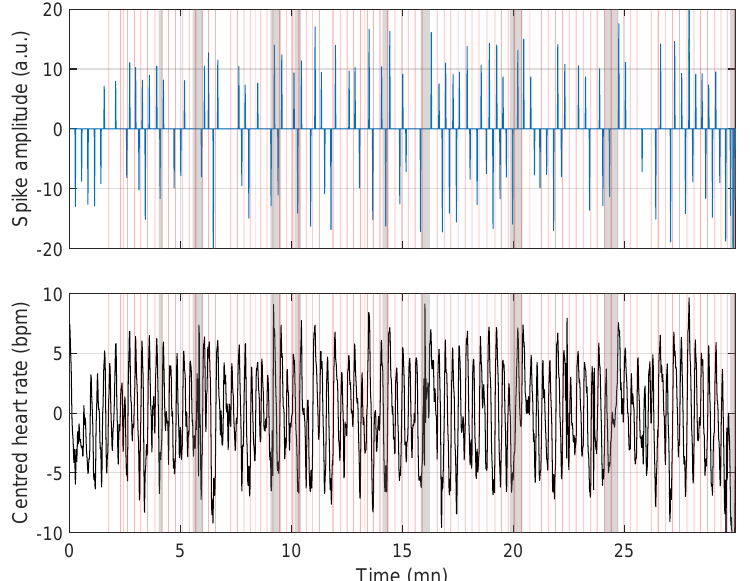
Figure 10. Example of over-detection using the same representation as in Figure 9; errors are explained by limb movement-induced cardiac responses (highlighted by the red patches). These have a similar heart rate profile to apnoea and are, therefore, detected as